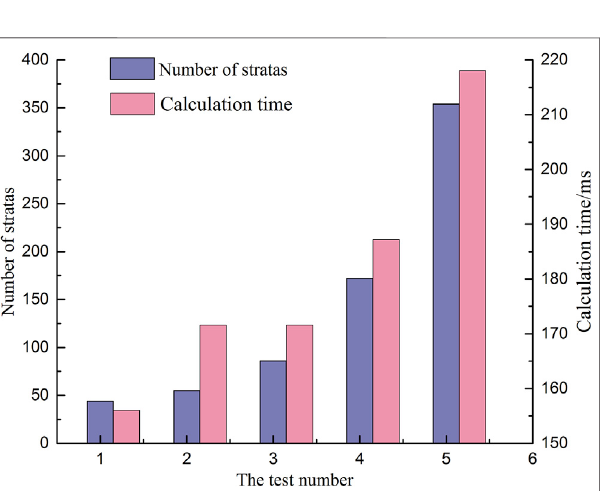
FIGURE 11 | aw of the calculation